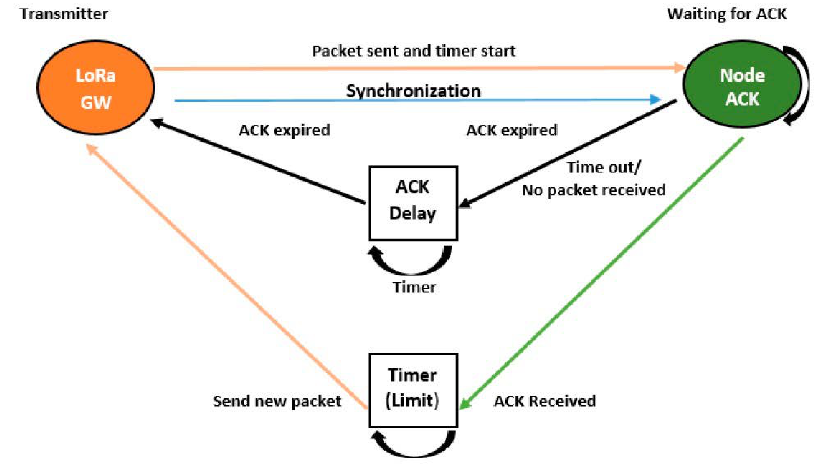
Figure 4. Failure of message integrity code.